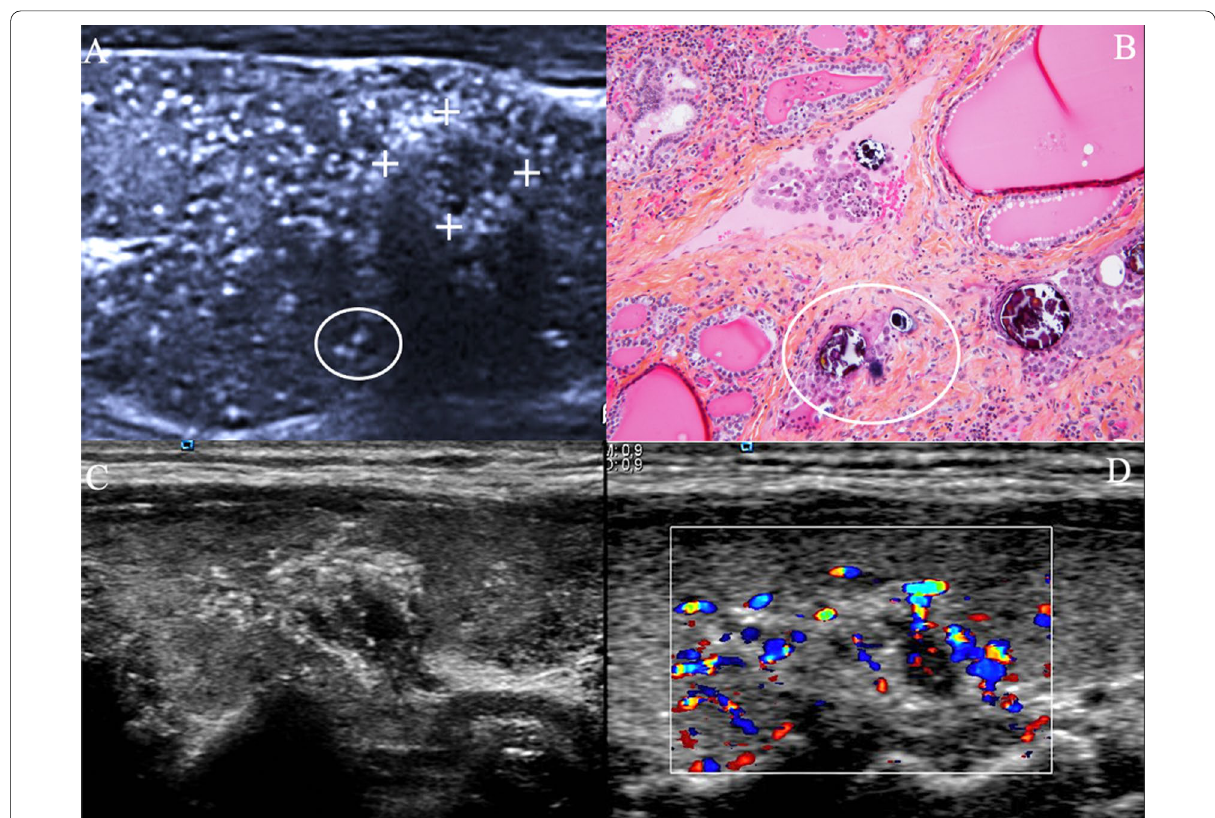
Fig. 2 US scan of two diffuse Sclerosing Variants (DSV) of PTC. Case 1 Longitudinal US scan of right lobe ( A ), histopathological specimen ( B , 20 ). × DSV shows diffuse extensive psammoma bodies (O) of thyroid lobe ( A , B ), usually without forming a gross tumour nodule. In the present case, a dominant 9 mm Eu-TIRADS4 anterior nodule T1a is displayed ( A , ). Case 2 Longitudinal US scan shows Eu- TIRADS5 posterior thyroid nodule ( C ); ++ Doppler US discloses twinkling artefacts of psammoma microcalcifications on Doppler US ( D ). TNM staging: the radiologist takes into account the PTC nodule size, whereas the histopathologist takes into account the nodule size but also the long axis of microcalcifications, which correspond to intra lymphatic intralobar thyroid tumour